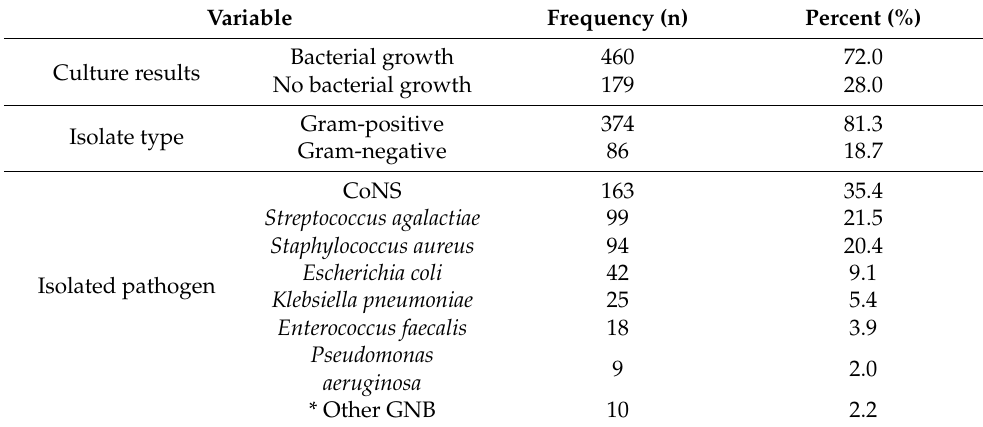
Table 2. Laboratory confirmation and distribution of pathogens causing neonatal sepsis.